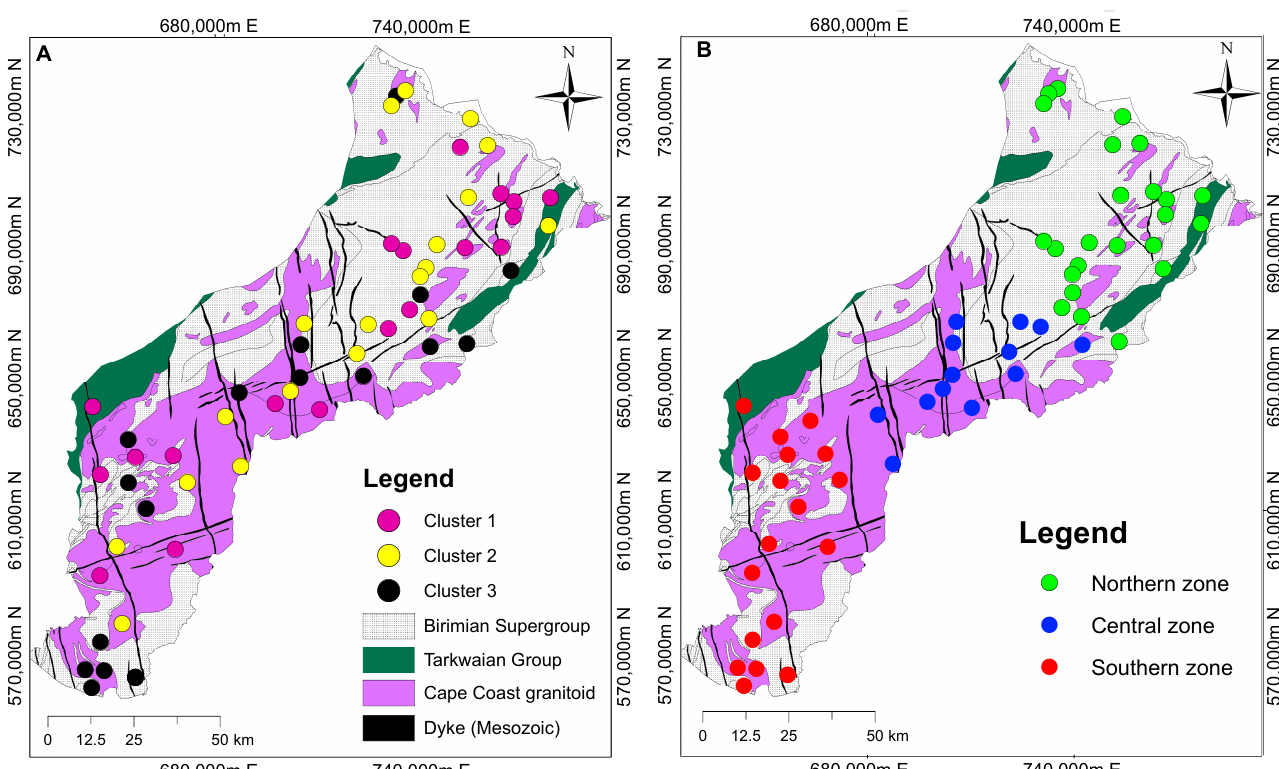
Figure 7. Hierarchical cluster analysis (HCA) of the hydrochemical dataset. ( A ) Taking into account only hydrochemical data, three clusters are identified with no apparent geographical proximity, highlighting large variability across the basin. ( B ) Considering elevation for the HCA, three spatially distinct clusters appear, dividing the basin into three zones: northern, central and southern. The elevation is highest in the northern zone and decreases towards the southern